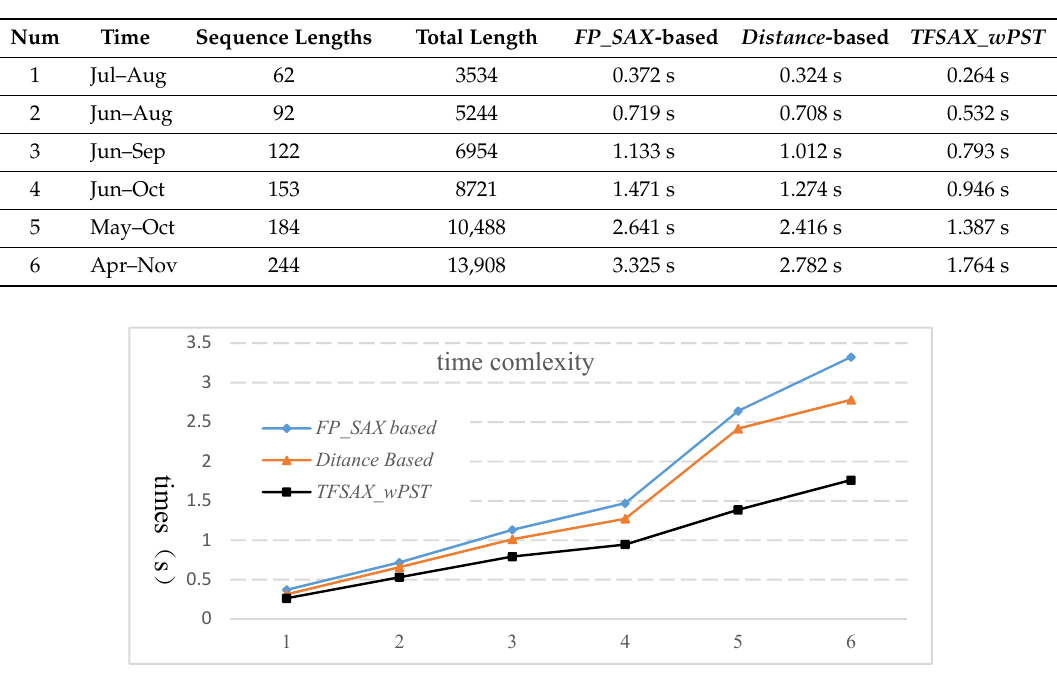
Figure 10. AUC for the different algorithms.